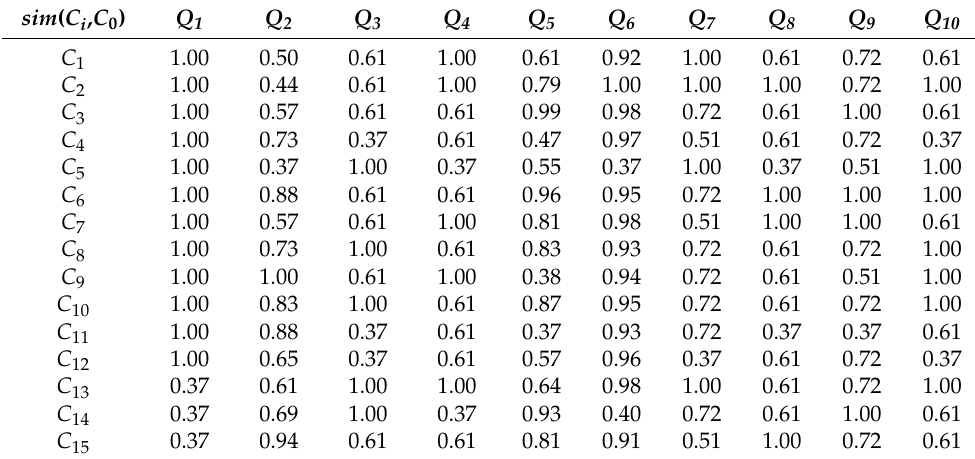
Table 5. Similarity measures of attribute Q j between historical enforcement cases C i and target enforcement case C 0